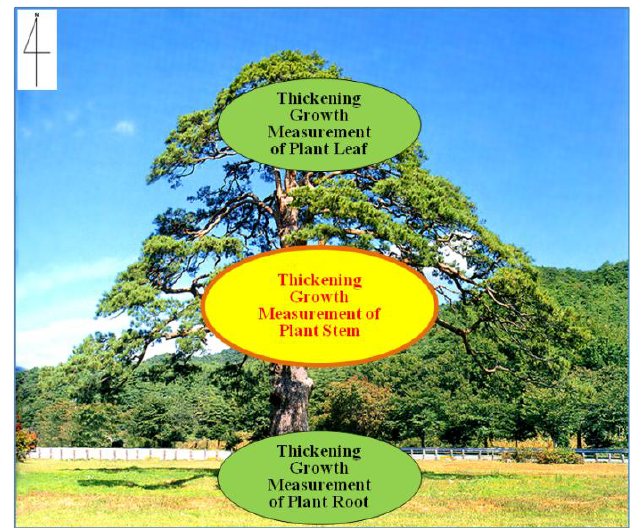
Figure 2. Plant growth measurement